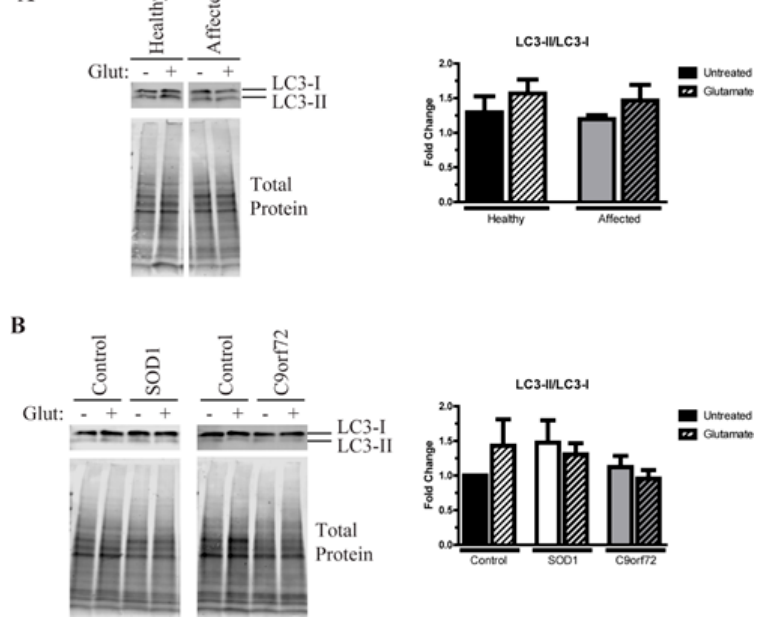
Figure 5. Alterations in autophagy in familial ALS (fALS) motor neurons. ( A ) The Western blot for LC3 shows similar levels of autophagy in affected and unaffected MNs at baseline, and MNs from both twins increase autophagic flux after treatment with 100 µM glutamate for 96 h. n = 4–7. ( B ) SOD1 MNs have an increase in the LC3-II/LC3-I ratio at baseline compared to control MNs, indicating a higher autophagic flux in these cells. Control MNs increase autophagy after a 96-h treatment with 100 µM glutamate, while the SOD1 and C9orf72 MNs do not. n = 5–7.